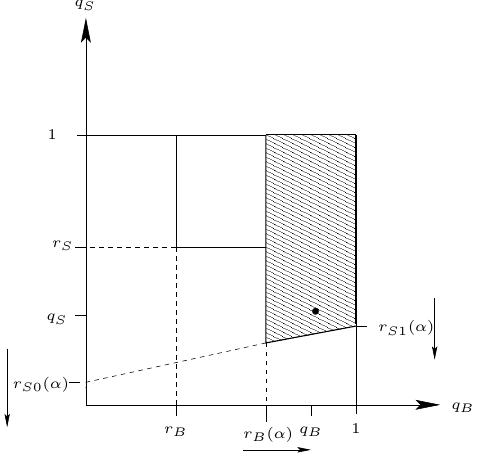
Figure 4. Ally-Ally becomes a Nash equilibrium when improved market performance is shared; the arrows show the direction of movement of the lines in Equations (4) and (5) as α